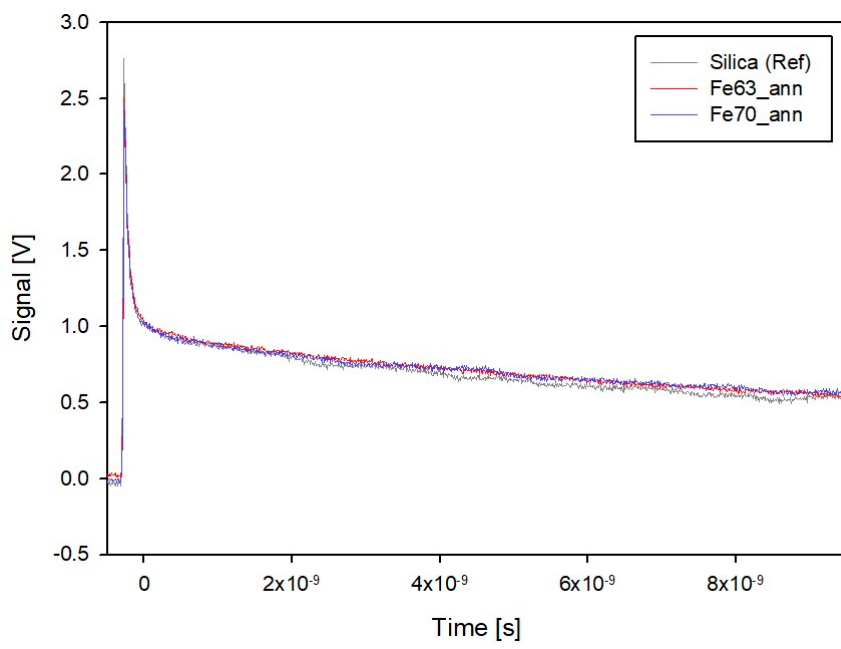
Figure A2. Thermo-reflectance signals of skutterudite samples.